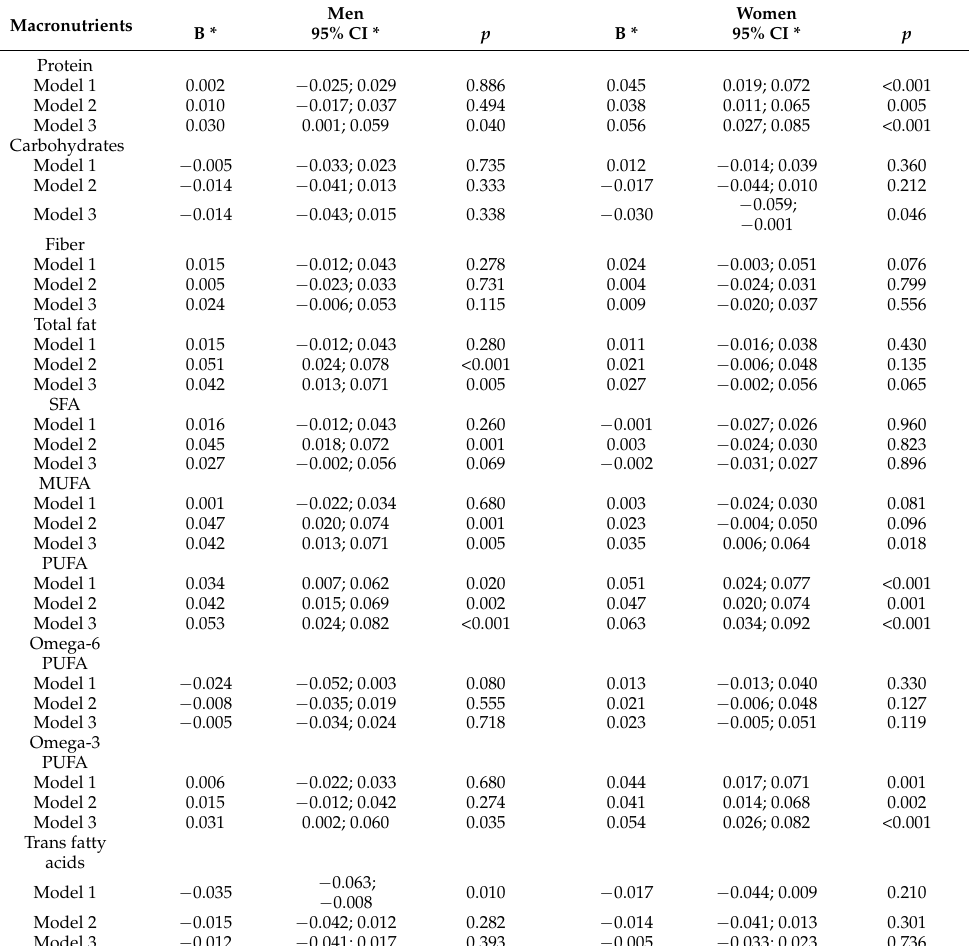
Table 3. Association between macronutrient intake and the ATHLOS Healthy Ageing Scale—results of the multivariable linear